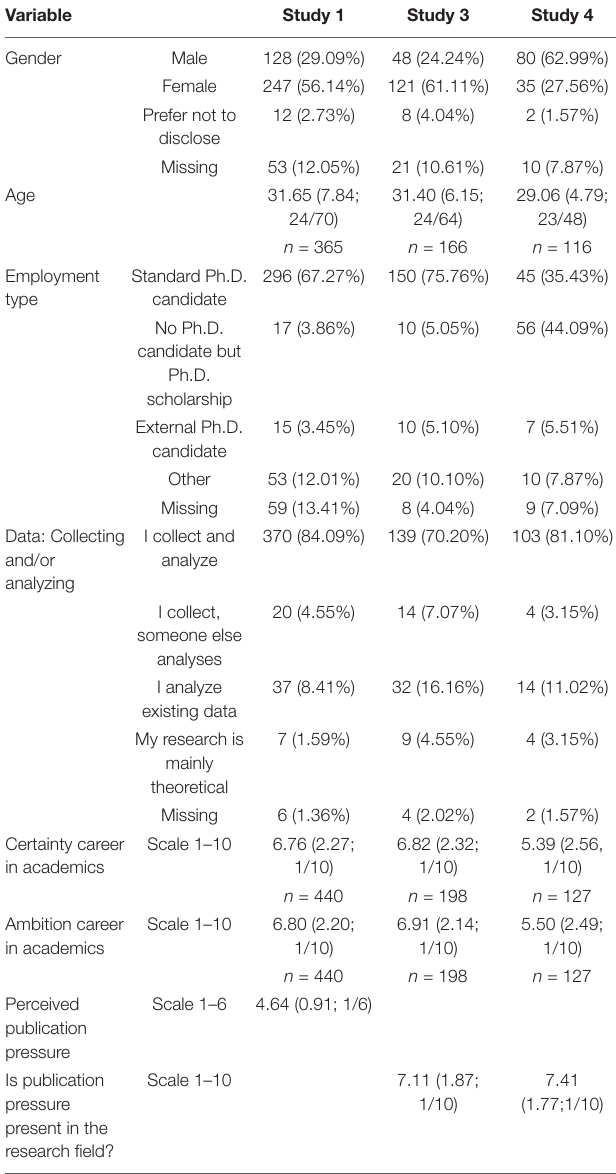
TABLE 1 | Descriptive statistics for Study 1 ( N = 440), Study 3 ( N = 198), and Study 4 ( N = 127).